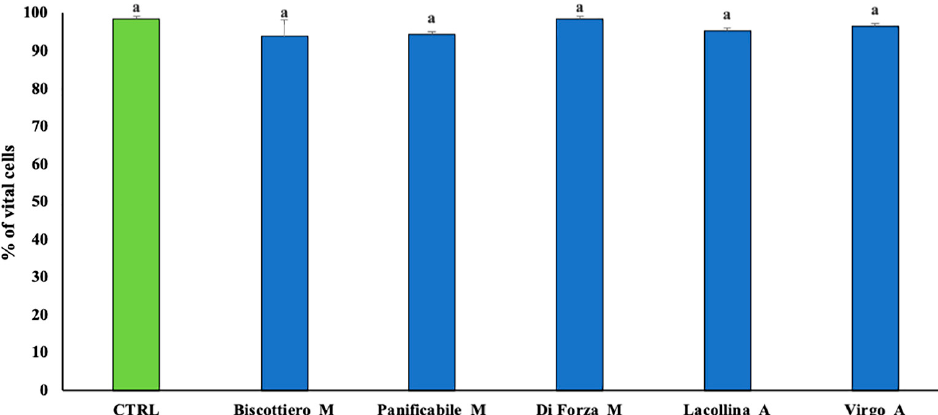
Figure 3. Cell vitality of U937 cells after a 24 h exposure to 40 µg/mL total protein (albumins + globulins + gliadins + glutenins) from three commercially available modern wheat mixes (denoted by M) and two old wheat mixes (denoted by A). The designation of the letters a, b, c, and d represents significant differences between varieties as determined by one-way ANOVA at the 95% confidence level ( p ≤